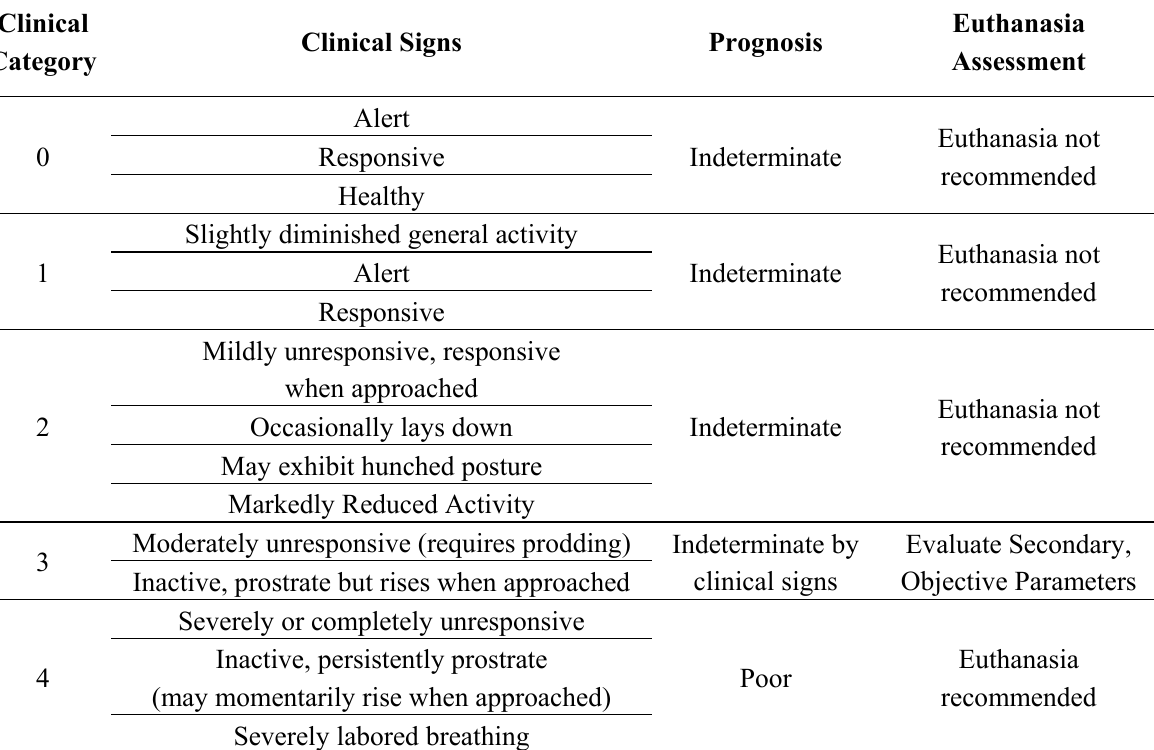
Table 1. Assessment of Euthanasia by Subjective Clinical